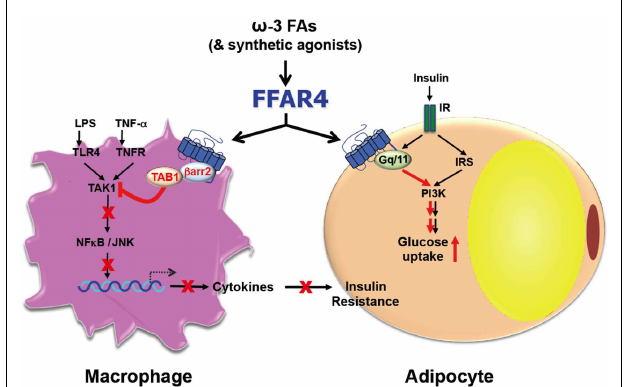
FIGURE 1 | Free fatty acid receptor 4 functions as an ω 3-FA receptor/ sensor to mediate broad anti-inflammatory and insulin sensitization effects